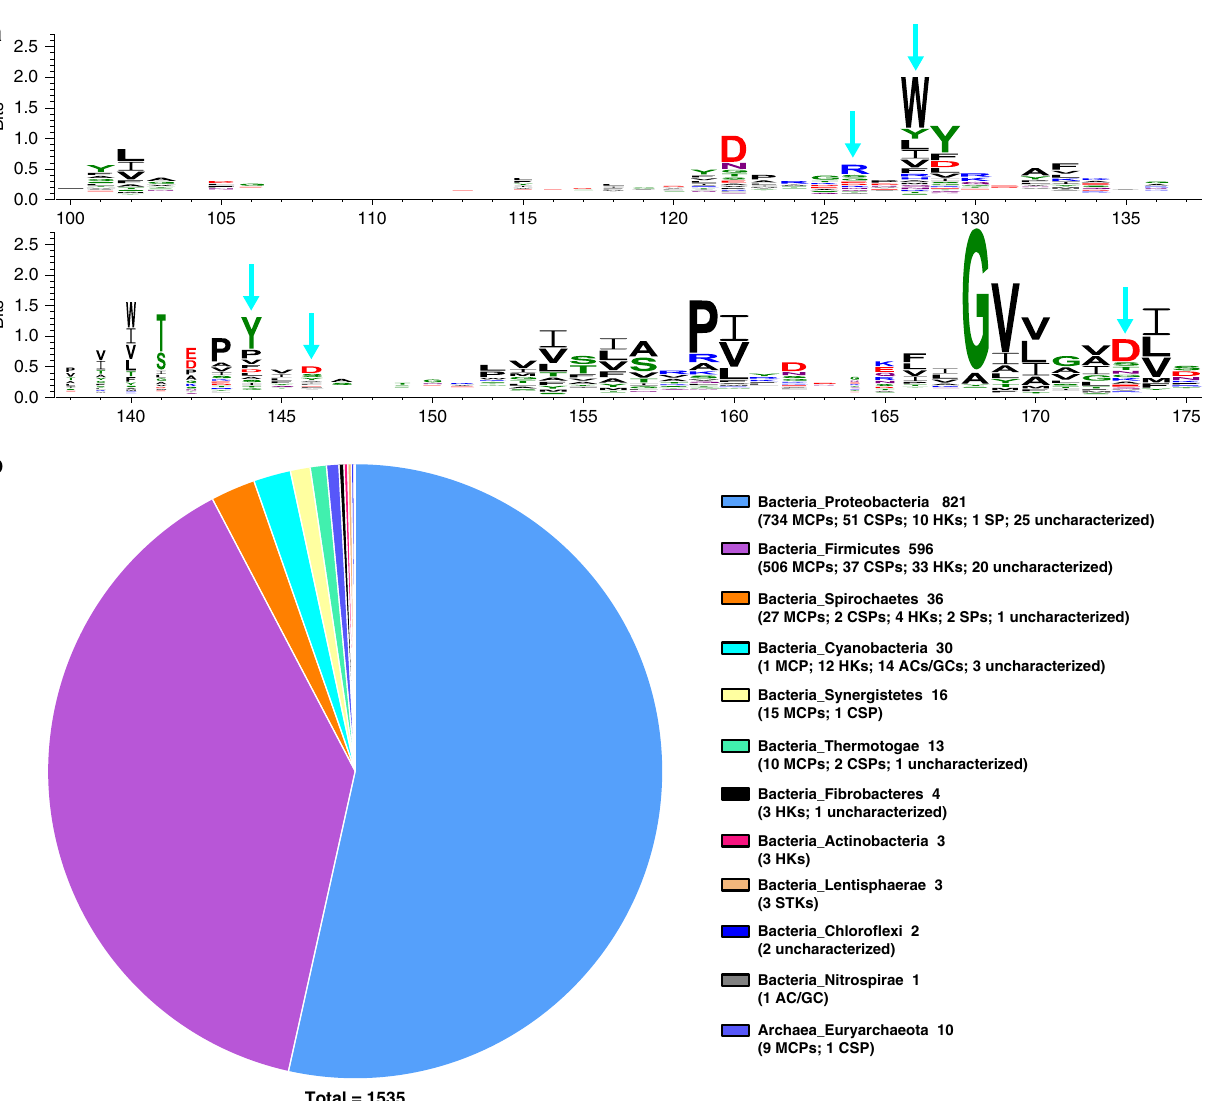
Fig. 6 Widespread occurrence of dCache_1-containing AI-2 receptors in bacteria and archaea. a A conservation pattern found in dCache_1 domains. Multiple alignment analysis of 18970 dCache_1 domains was performed with ClustalW embedded in MEGA7 (Supplementary Data 3). The region corresponding to the active pocket of PctA-LBD (residues 100 – 175) is illustrated using WebLogo 3. Cyan arrows above the WebLogo denote the fi ve highly conserved positions corresponding to R126, W128, Y144, D146, and D173 of PctA. b Distribution of 1535 dCache_1-containing proteins with all the fi ve conserved residues corresponding to R126, W128, Y144, D146, and D173 of PctA at the phylum level in prokaryotes. The number of occurrences for each type of signal transduction proteins is listed in